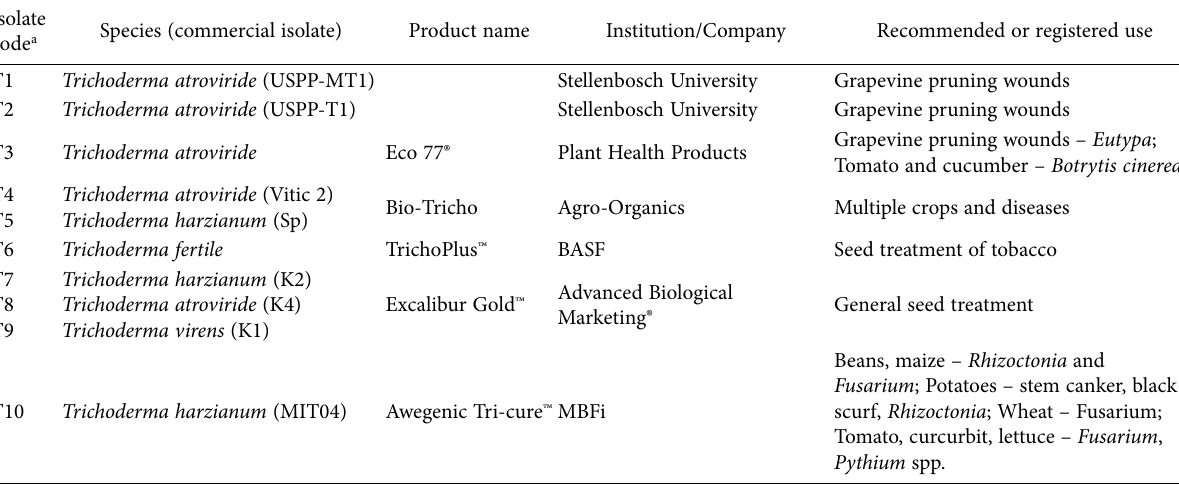
Table 1. Trichoderma products and isolates used in this